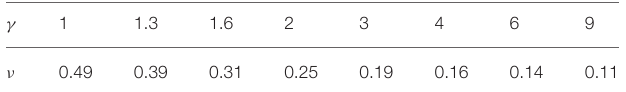
TABLE 1 | Peak enhancement factor against spectral